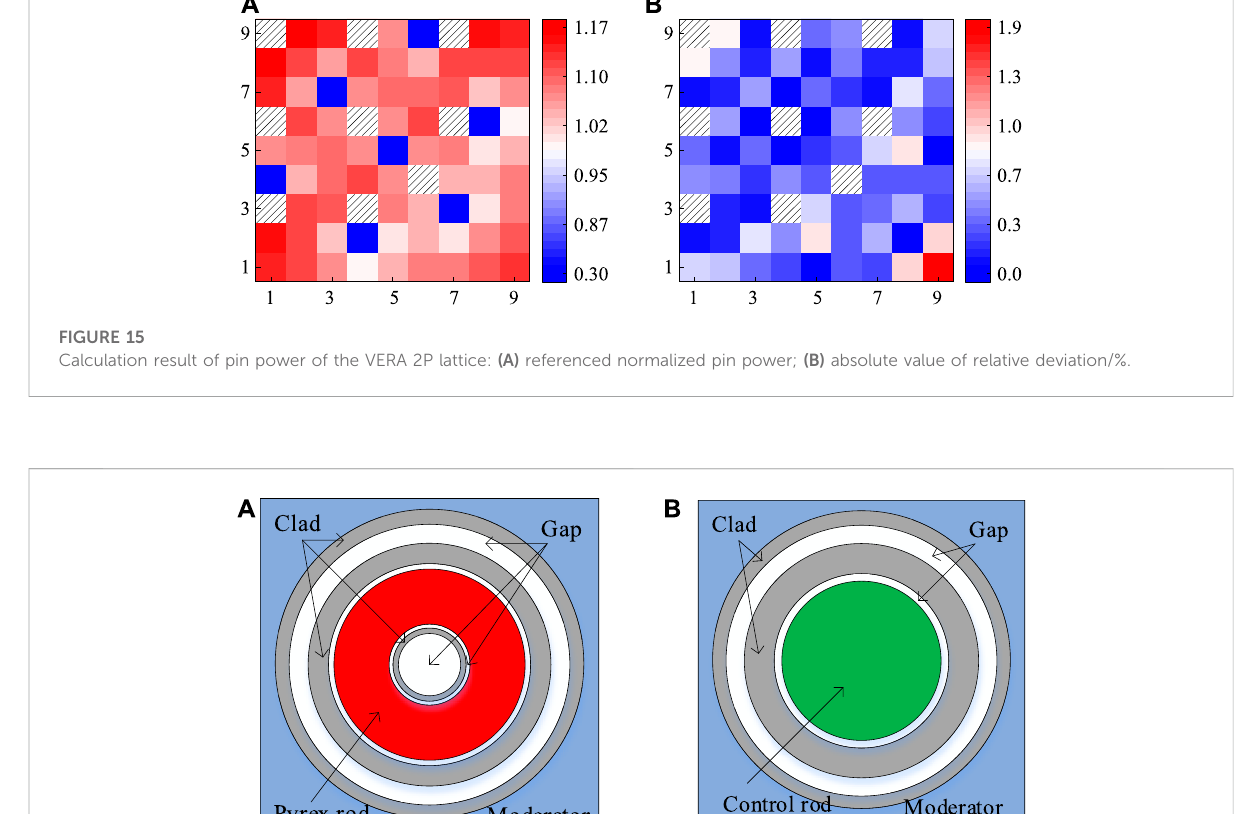
FIGURE 16 Structural con fi guration of the rod with strong absorber: (A) Pyrex rod; (B) control